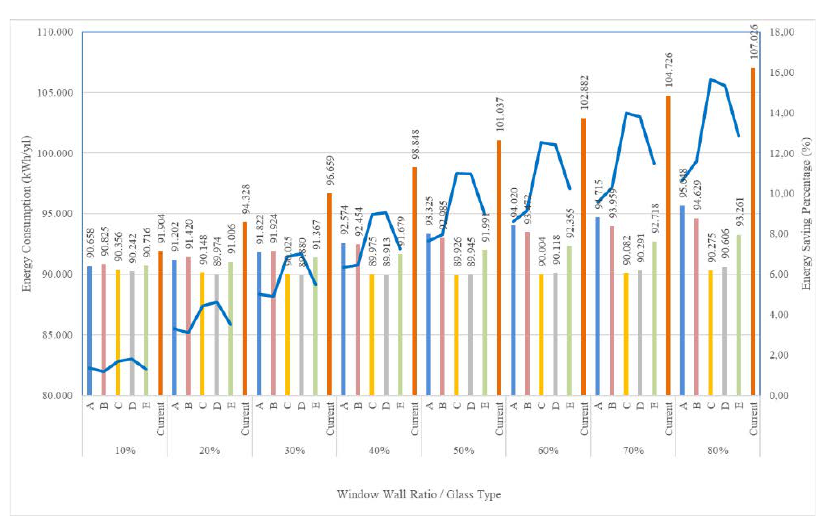
Figure 8 Energy saving rates, calculated energy consumptions and reference energy consumptions for Northwest